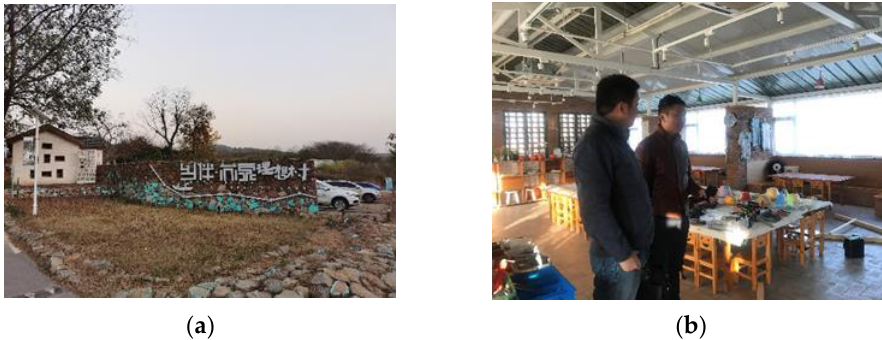
Figure 10. Current situation of Sujia village construction: ( a ) statue with village vision at the entrance of Sujia Village; and ( b ) communication with the village manager in Lvleyuan.